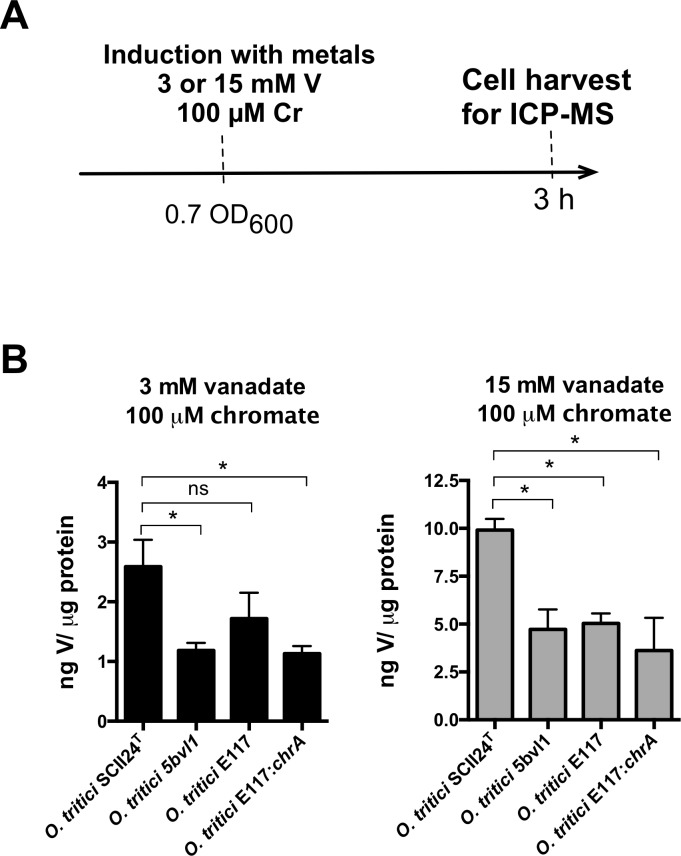
Vanadate intracellular accumulation by O. tritici SCII24T, 5bvl1, E117, E117:chrA strains after vanadate (3 or 15 mM) and chromate (100 μM) induction for 3 h at 30 °C.Results are the intracellular concentrations of V after normalization for protein content (mean ± SD, n = 2) ns, not significant; *, p < 0.05.